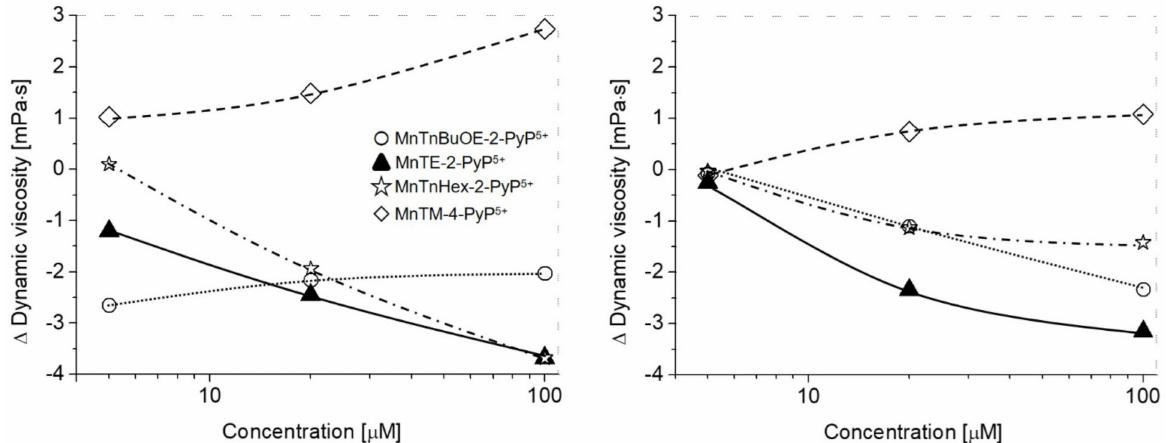
Figure 3. Concentration-dependent changes in dynamic viscosity of HA solutions exposed to oxidative degradation by Cu(II) (1 µ M) and ascorbic acid (100 µ M) in the presence of MnTnBuOE-2-PyP 5+ (circles, dotted lines), MnTE-2-PyP 5+ (triangles, solid lines), MnTnHex-2-PyP 5+ (stars, dash-dotted lines) or MnTM-4-PyP 5+ (diamond, dashed lines) at concentrations of 5, 20 and 100 µ M. The concentration of HA was 1.75 mg/mL. Left panel —MnPs were added to the HA mixture before initiating HA degradation. The 60 min data are shown. Right panel —MnPs were added to the HA mixture 1 h later. The 120 min data are shown.